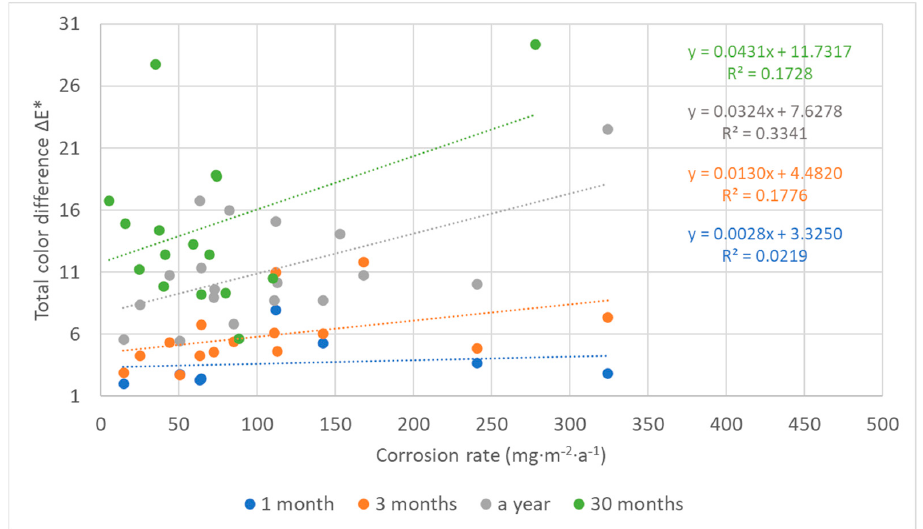
Figure 21. Comparison of corrosion rates of copper based on mass losses after 1-year exposure with total color changes after 1, 3, and 12 months, and mass losses after 30 months with color changes after the same time (locations 3, 4, 6, and 7 were excluded in the case of 1-month and 3-month ex- posures).